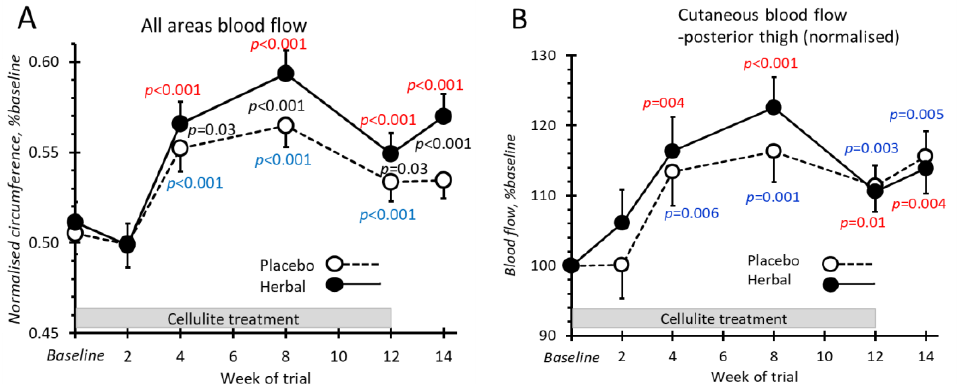
Figure 7. Cutaneous blood flow by laser Doppler flowmetry. All p -values colour coded as Figure 3.